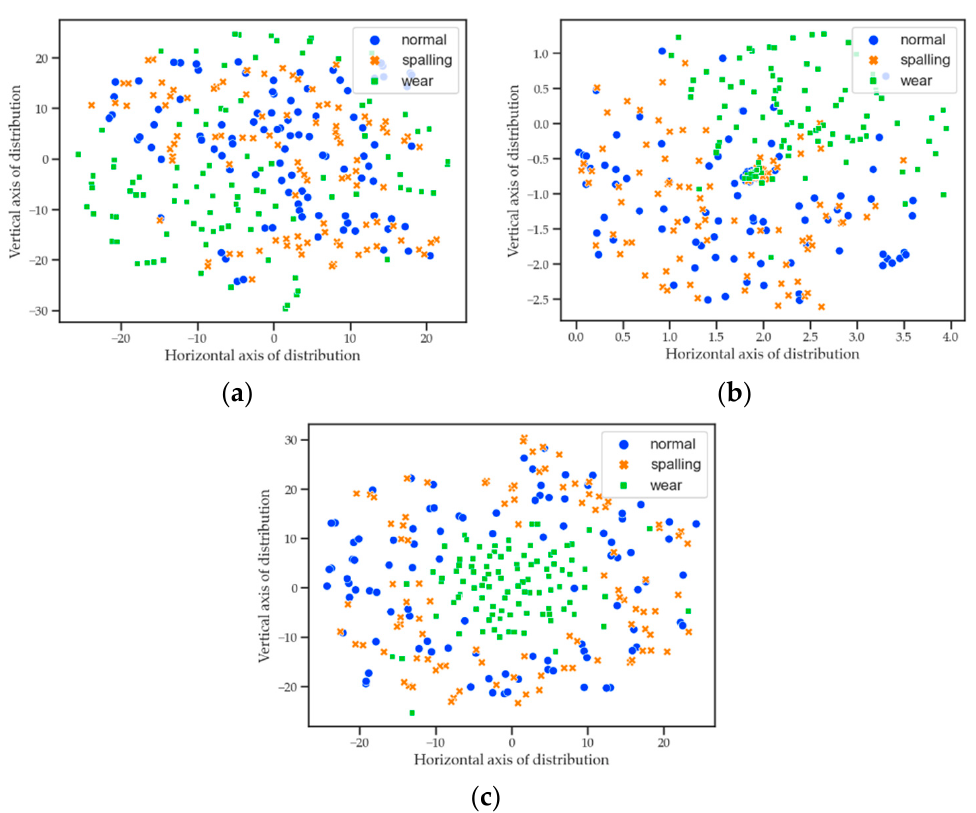
Figure 8. Visualized feature distributions; ( a ) distribution of the time-domain dataset; ( b ) distribution of features extracted from the time-domain dataset by KPCA; ( c ) distribution of features extracted from the time-domain dataset by the SDAE.